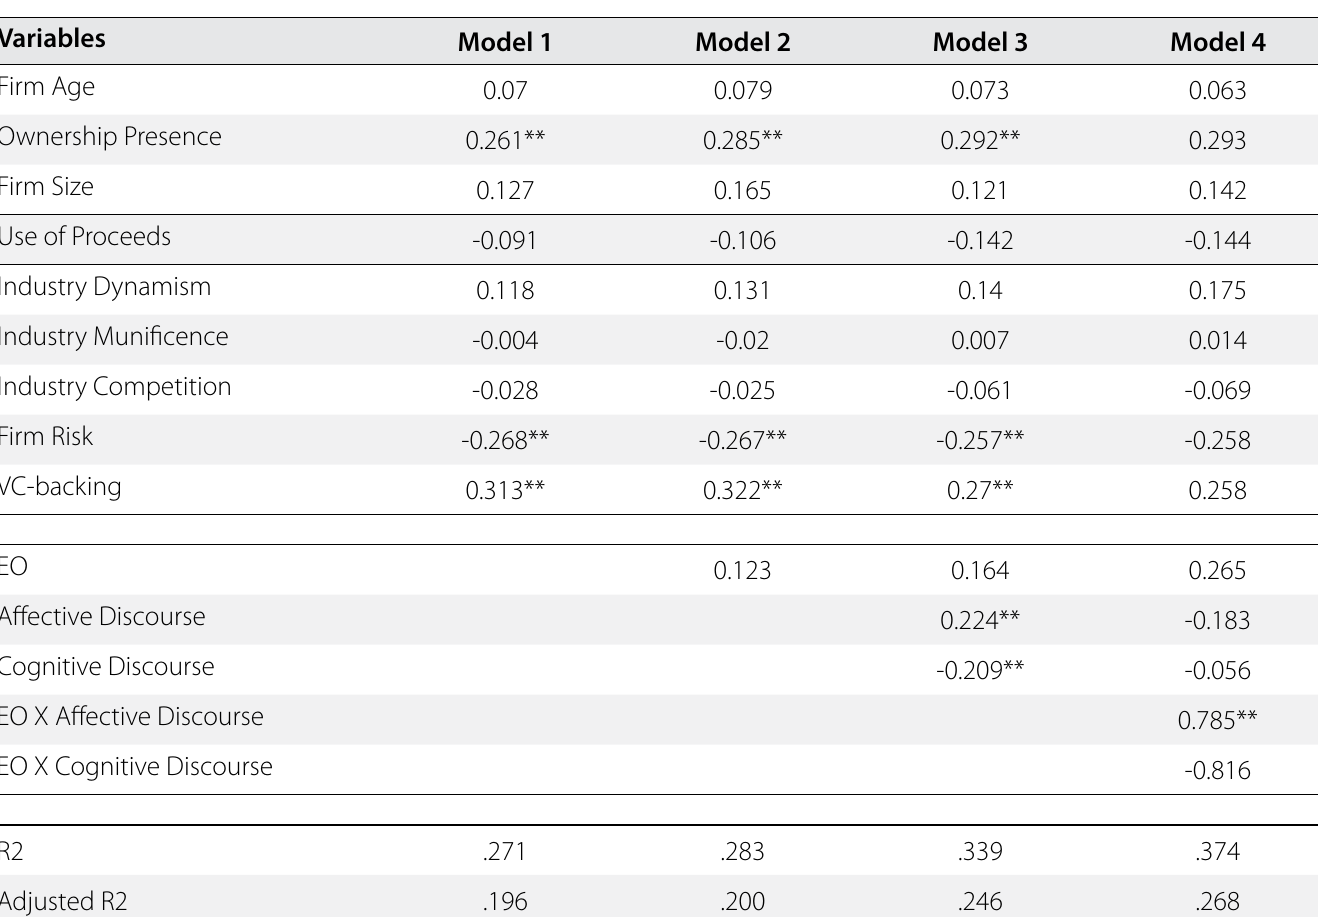
Table 2: Results of Linear Regression Predicting